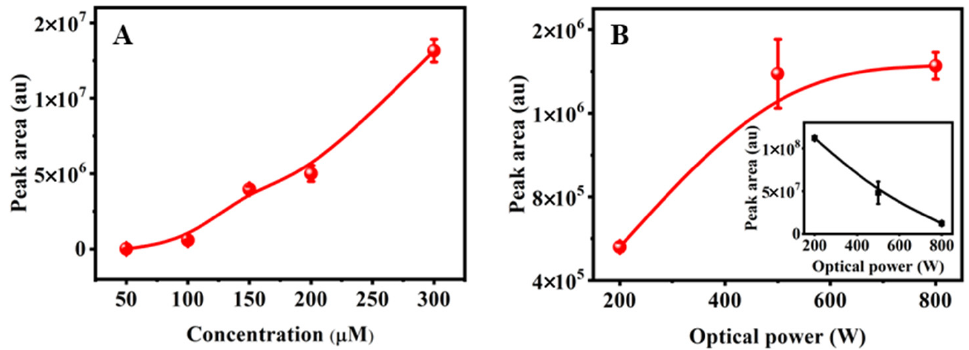
Figure 2. ( A ) The formation of transformation product dimer under different the initial concentration of EPB; ( B ) optical power at 90 min of photodegradation. The inset showed remaining EPB peak area.